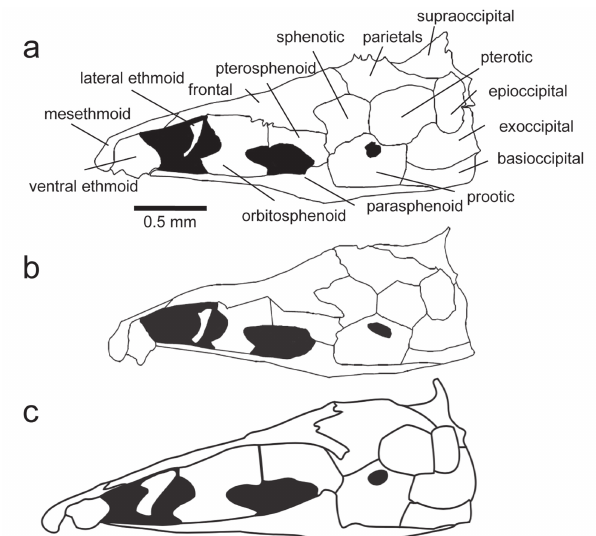
Fig. 2. Illustrations of neurocrania in lateral view of species in the Sternarchella calhamazon clade. a. Sternarchella patriciae (MUSM 45234) showing the ‘crown of thorns’ at the border of the parietal and supraoccipital bones. b. Sternarchella calhamazon (USNM 373113), showing the smaller and triangular ventral ethmoid. c. Sternarchella rex paratype (MCP 49423).